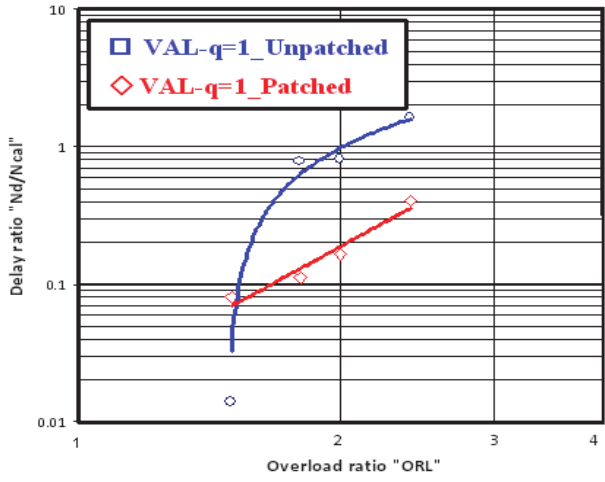
Figure 9: Retard ratio